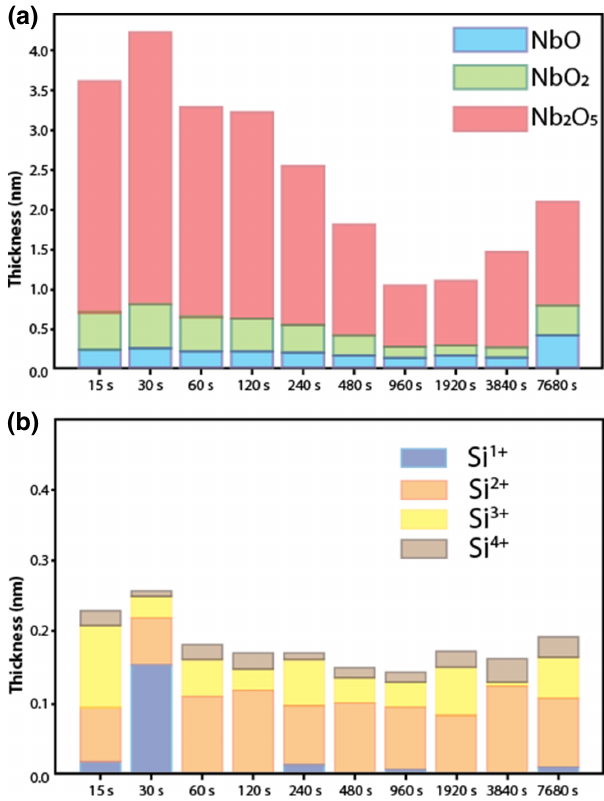
FIG. 13. The etching of Nb (a) and Si (b) process oxides on unpatterned substrates. Moving from left to right, the etch time is doubled for each successive histogram bar. The minimum NbO x thickness is reached after approximately 1000 s, consistent with oxide removal followed by reoxidation. The SiO x thickness is approximately a monolayer, independent of the etch time, which is also consistent with the complete removal of the process